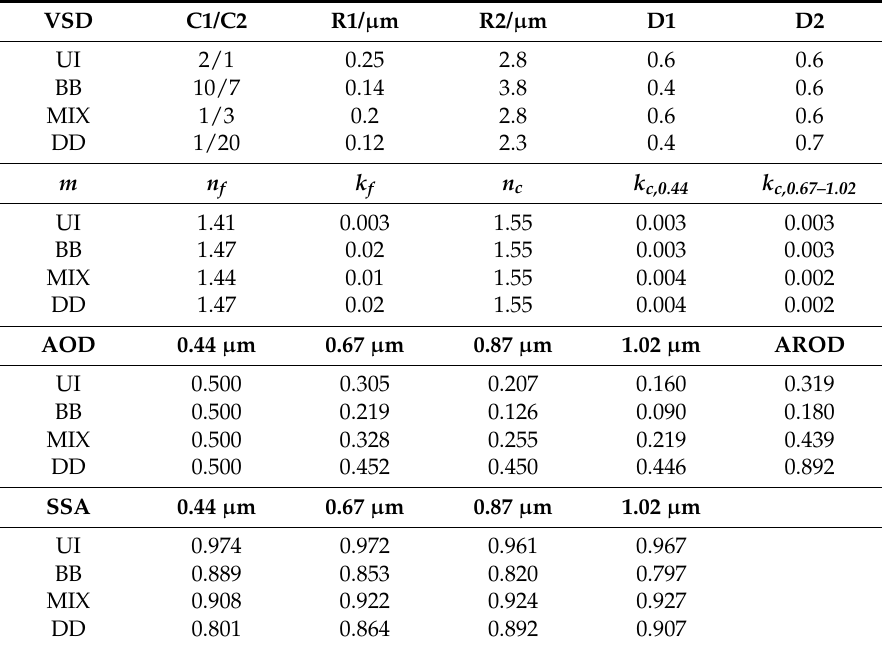
Table 2. Inputs of the aerosol models used in this